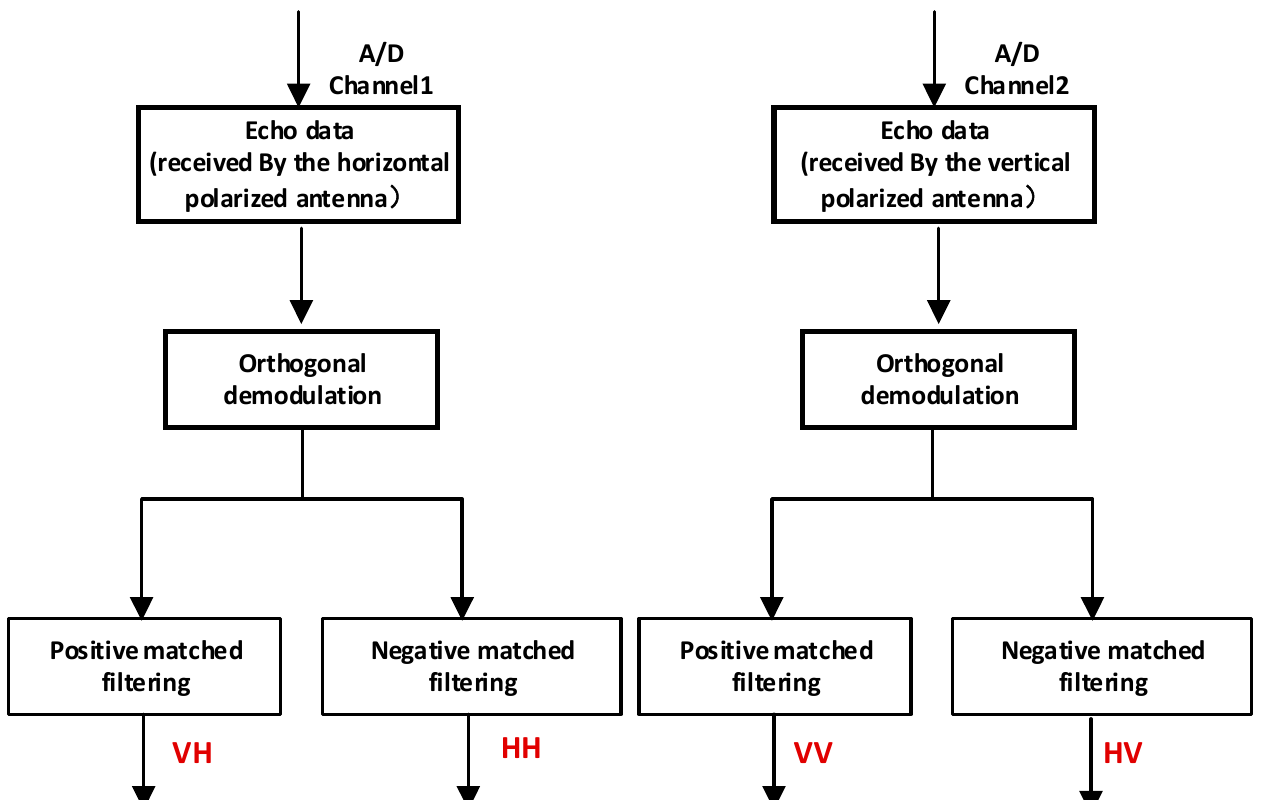
Figure 4. The acquisition of the fully polarimetric radar echo.